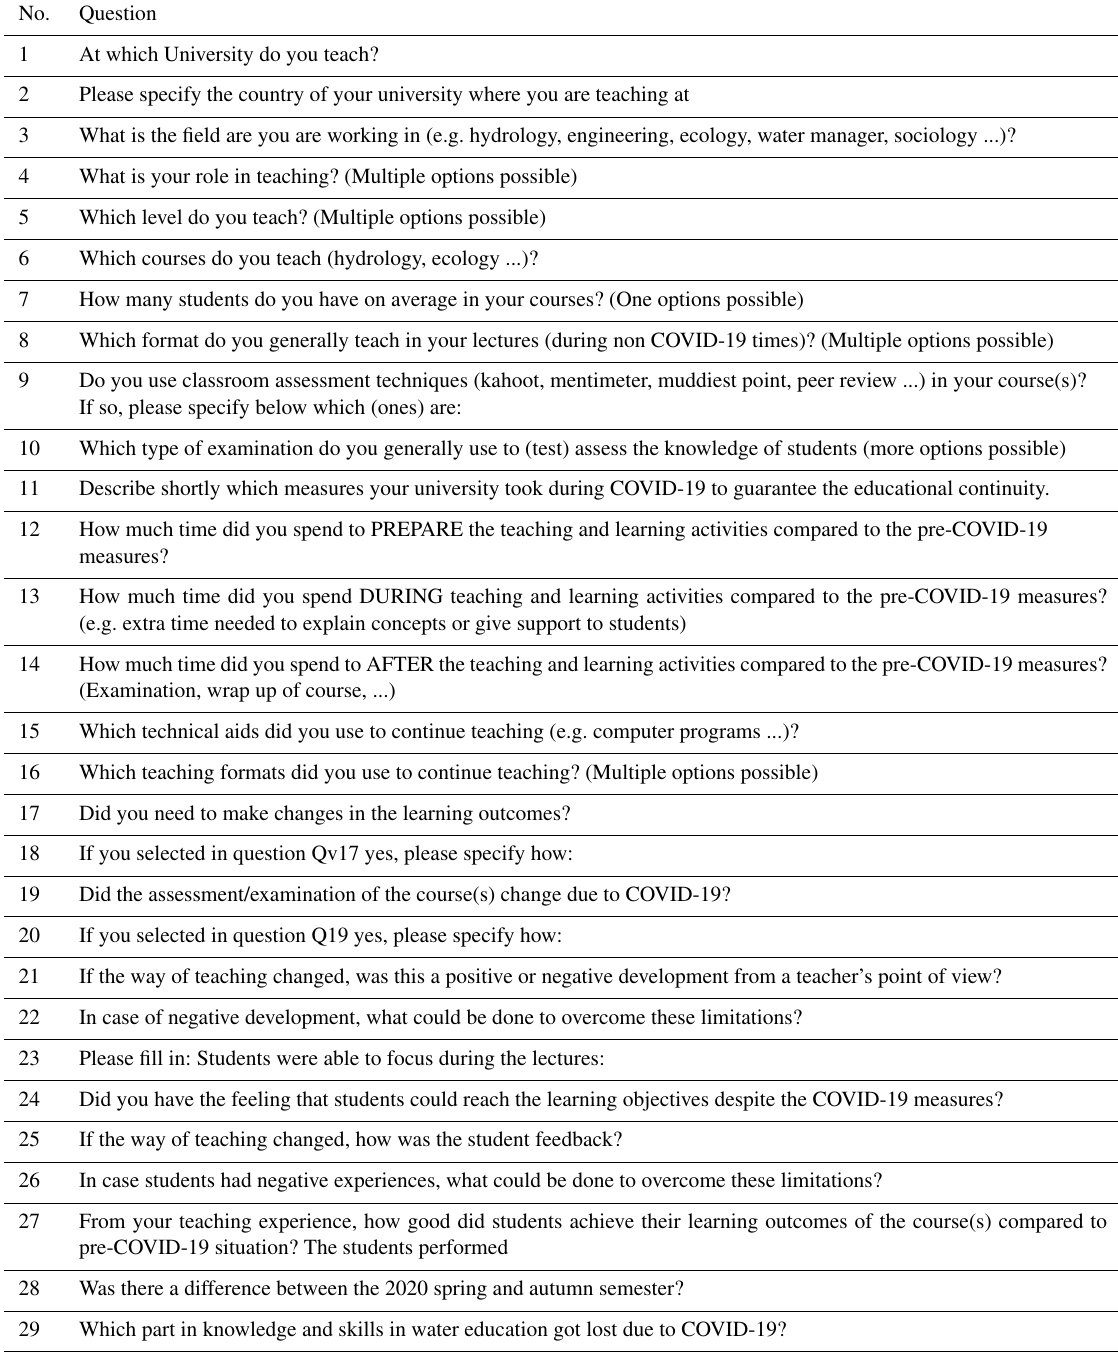
Table A1. Questions from the survey “The effect of COVID-19 on water